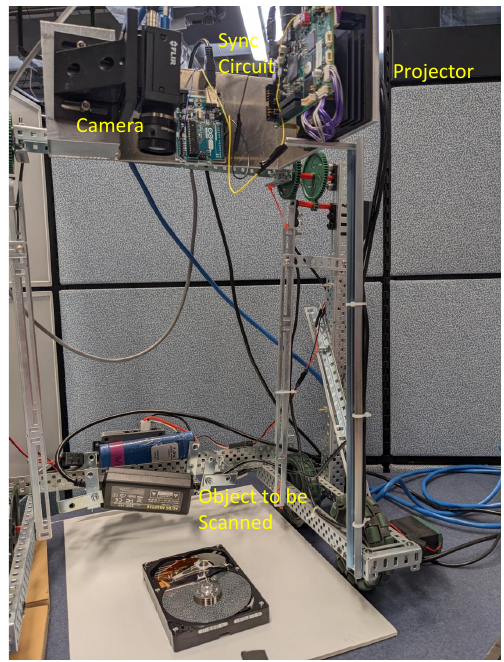
Figure 1. Physical setup of a FPP